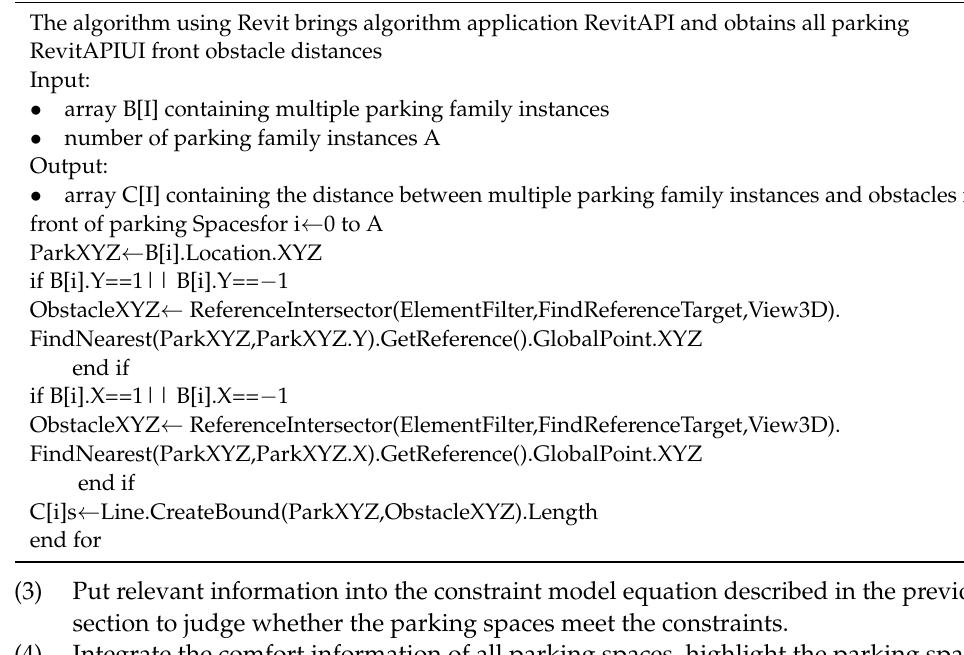
Algorithm 1: Judge the position of obstacles in front of parking spaces.